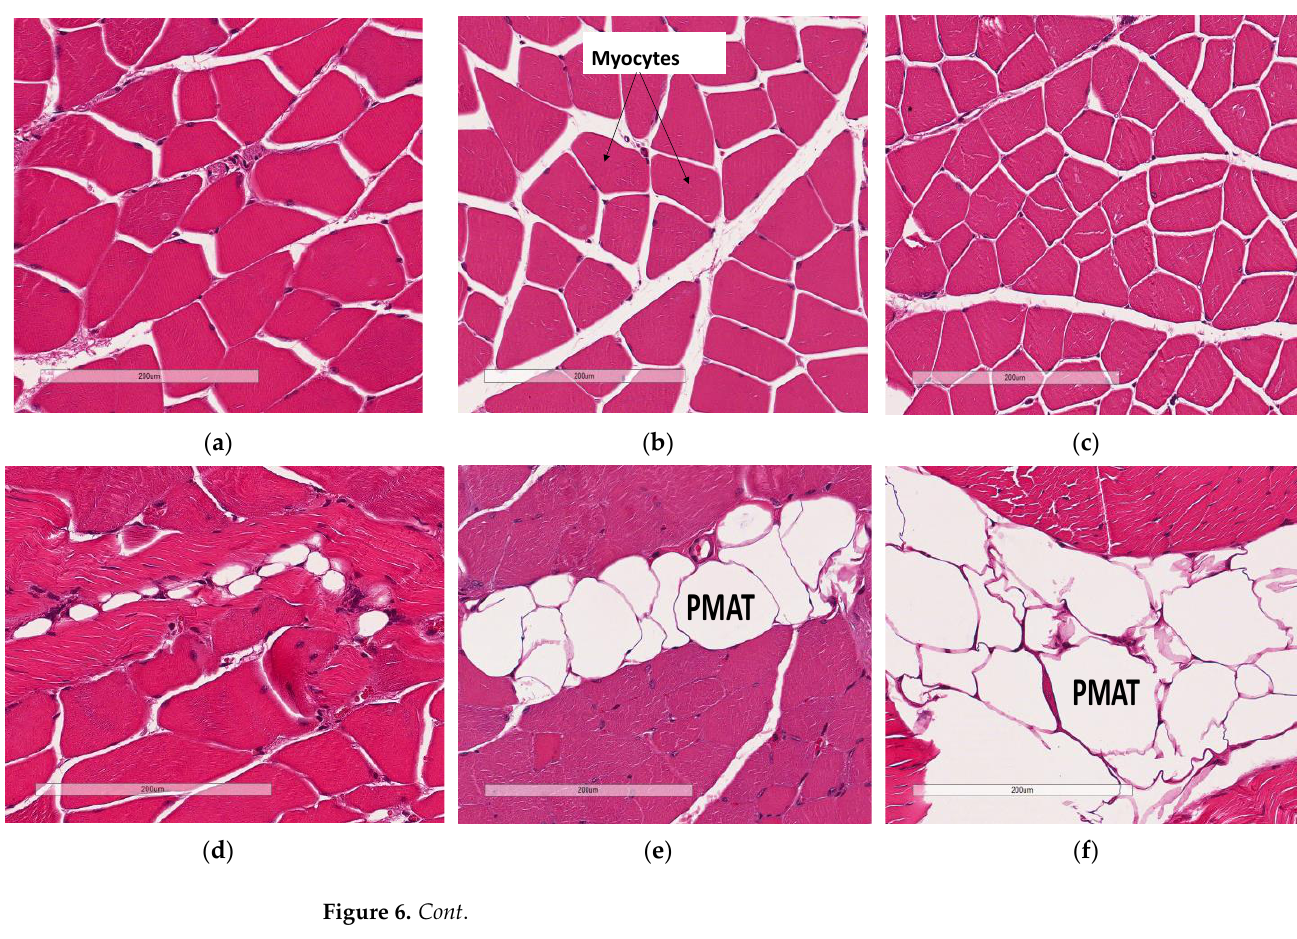
Figure 5. Lipid accumulation in the liver. H&E-stained liver sections showed the presence of micro- and macrovesicular steatosis in WTHFD ( c ), which was reduced in KOHFD ( b ) and absent in WTCD ( a ). Magnification = 20×. Scale bar = 200 µm.